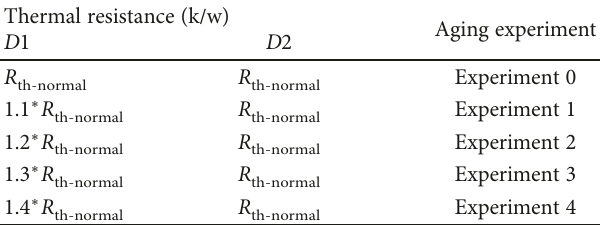
Figure 9: The picture of experiment rig. Table 1: Thermal aging experiment.